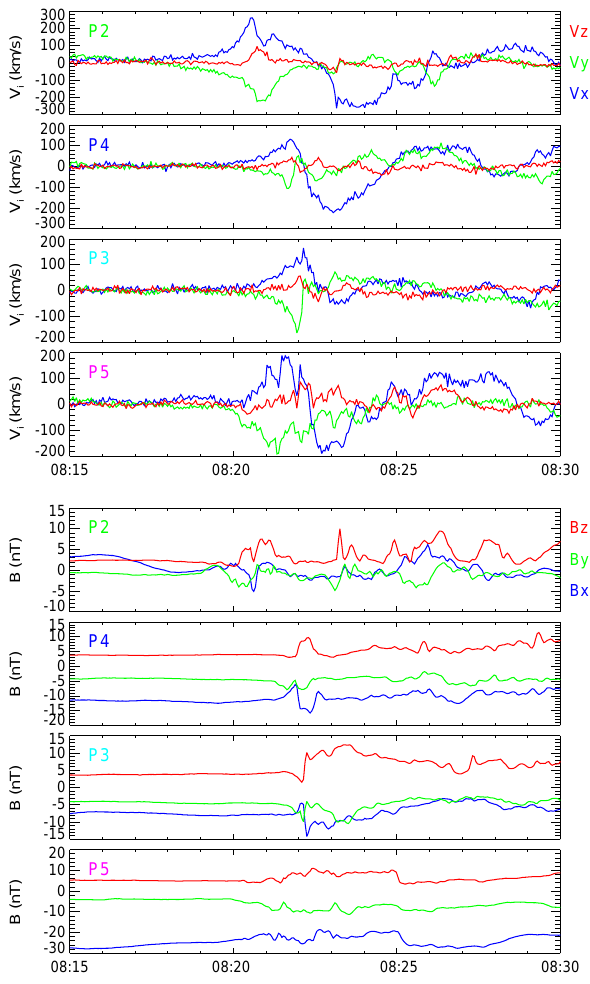
Fig. 3. Velocity (top) and magnetic field (bottom) GSM components from four THEMIS satellites (P2, P3, P4, and P5) on 1 March 2009 between 08:15 and 08:30UT. See legends for color coding.